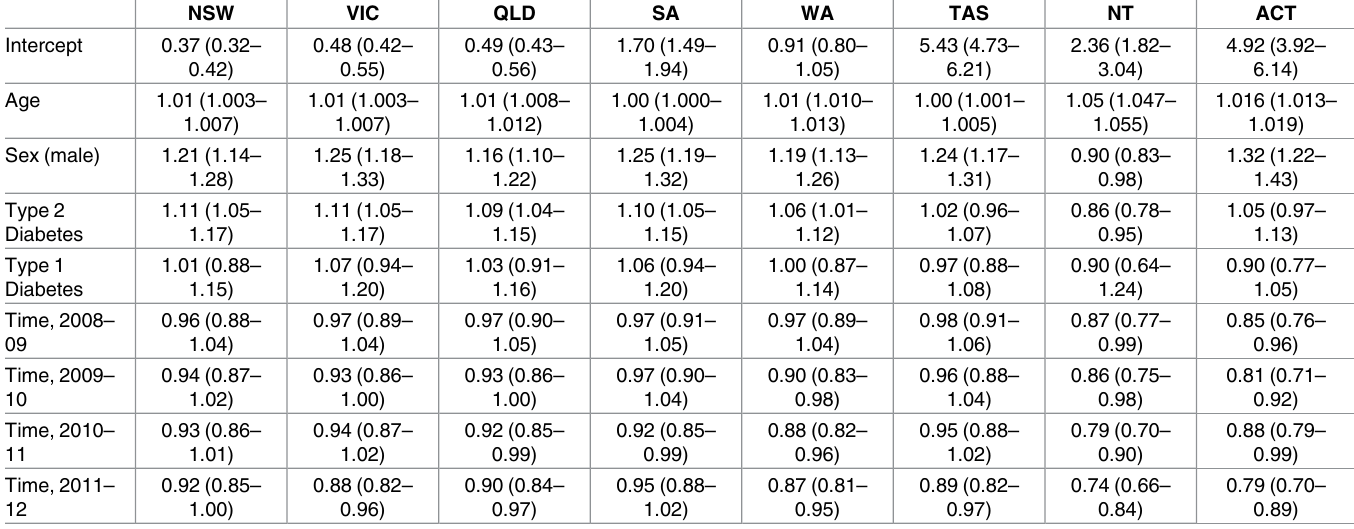
Table 3. Relative risk and 95%CI (in brackets) describing the influence of the independent variables on the crude incidence rate of lower limb amputation. The relativerisk for each year is expressedrelative to the baselineyear